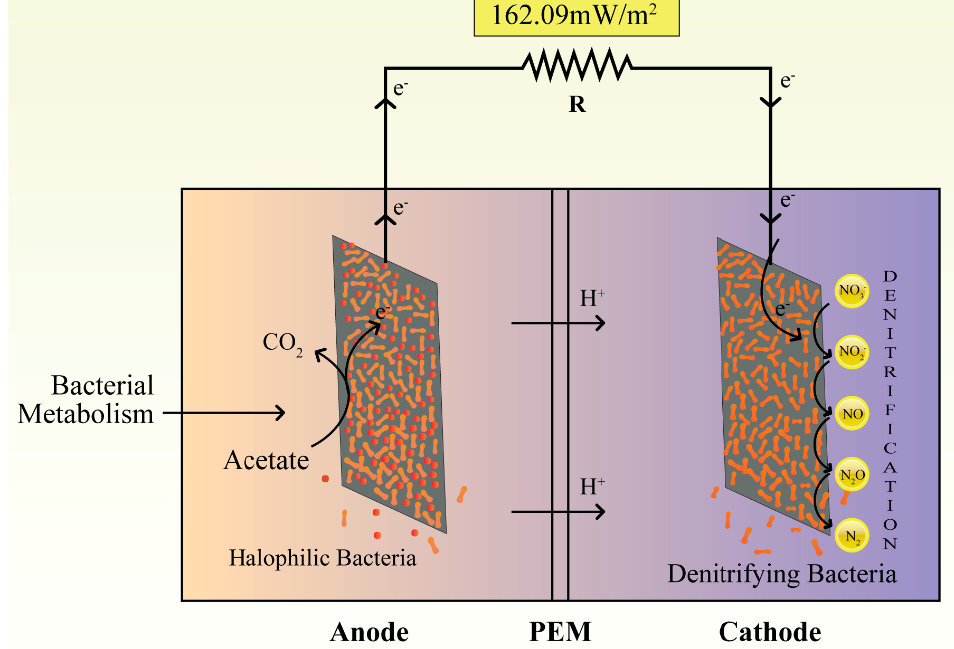
Figure 1. Schematic diagram of the MFC.